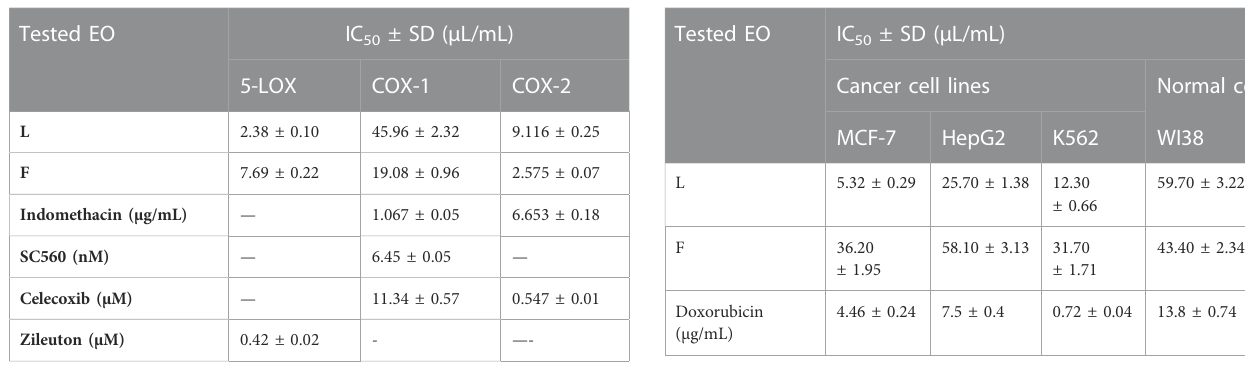
TABLE 4 IC 50 of P. cattleianum leaves (L) and fl owers ’ (F) essential oils against cancer cell lines (MCF-7, HepG2, K562) and normal cell line